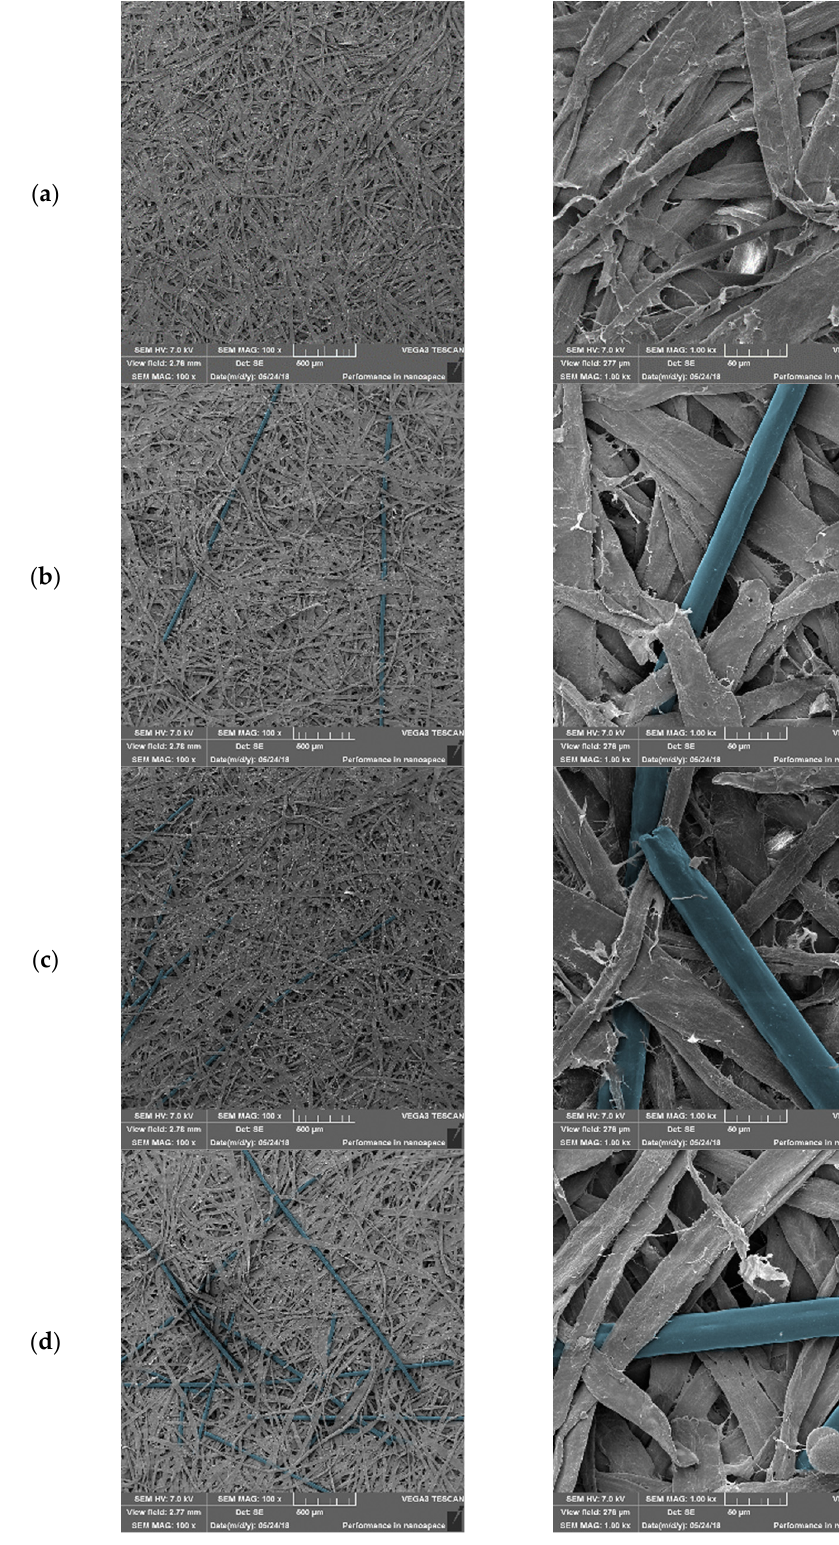
Figure 6. Comparison of the morphology of the paper samples containing 0 ( a ), 5 ( b ), 10 ( c ), and 20% ( d ) of PAN–PDA fibres. Left collumn: magnification ×100, inside scale 100 µm) and right collumn: ×1000, inside scale 50 µm (scanning electron microscopy analysis). The sample without PAN–PDA was not irradiated, whereas other samples absorbed the dose of 5 J/cm 2